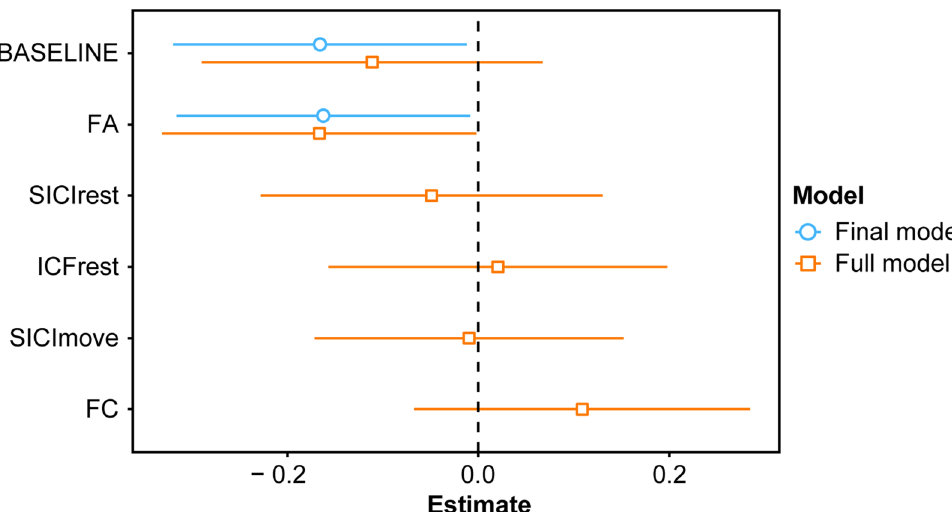
Figure 6. Effect plot depicts weights of beta coefficients (estimates) for full (orange) and final (blue) multiple linear regression model predicting training gain. Assessed predictors: (1) BASELINE—performance in the SFTT at baseline, (2) SICI rest at preD1, (3) ICF rest at preD1, (4) SICI move modulation at preD1, (5) mean FA within the SCP mask, (6) FC between the left cerebellum and right M1. Final model was obtained by stepwise backward selection based on the Akaike information criterion (AIC). Margins of error depict 95% confidence